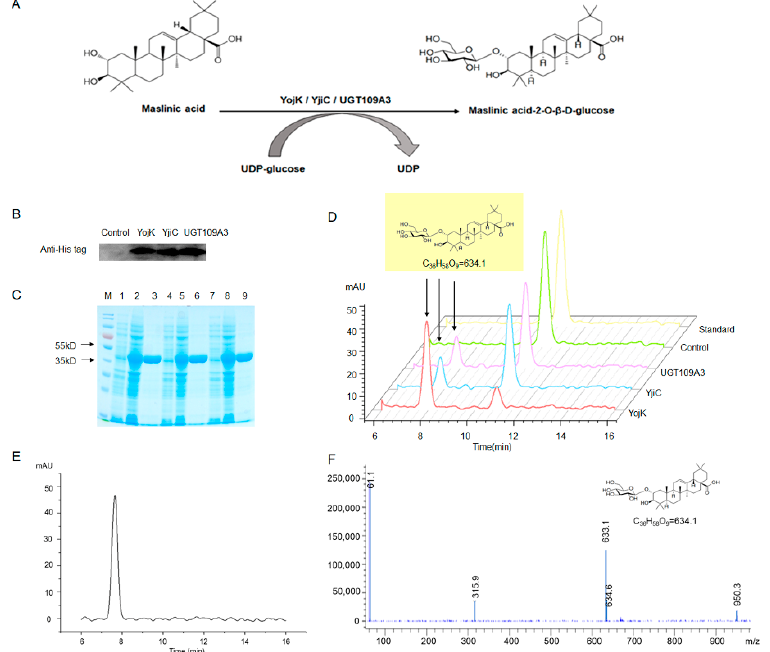
Figure 1. Enzymatic glycosylation of MA with YojK, YjiC, and UGT109A3. ( A ) The glycosylation schematic of MA to MA-2-O- β -D-Glu by YojK, YjiC, and UGT109A3. Western blot ( B ) and SDS-PAGE ( C ) analysis of YojK, YjiC, and UGT109A3 expression. ( D ) HPLC analysis of MA glycosylation by YojK, YjiC, and UGT109A3. M: protein marker; lane 1, 4, and 7: control; lane 2, 5, and 8: YojK, YjiC, and UGT109A3 cell lysate respectively; lane 3, 6, and 9: Purified YojK, YjiC, and UGT109A3, respectively. HPLC ( E ) and LC-MS ( F ) analysis of purified MA-glycoside product.